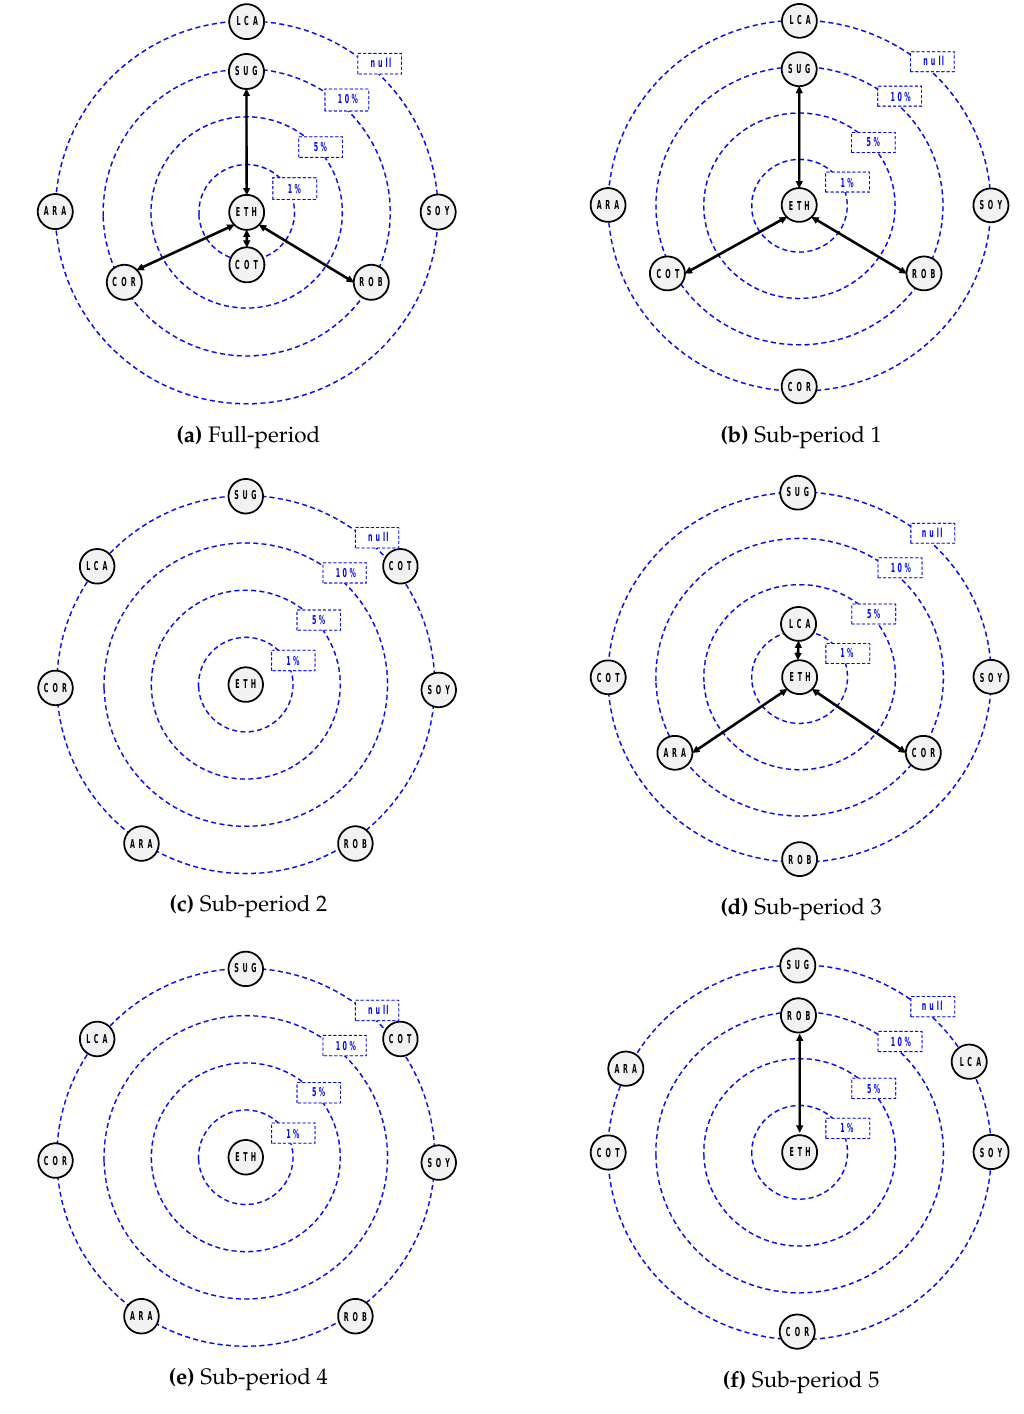
Figure 2. The observed cointegration processes between the considered pairs, and its corresponding significance levels (1%, 5%, 10% and null) for the studied periods. The double-headed arrows represent the cointegration process between the commodity